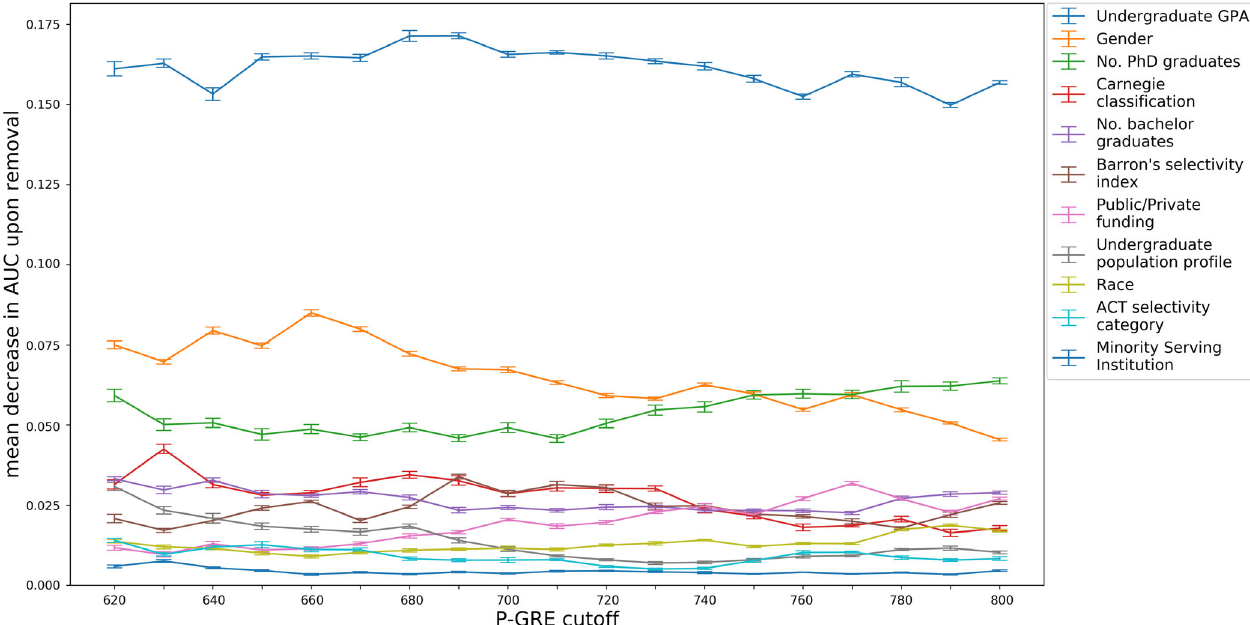
FIG. 5. Conditional inference forest feature importance measures. The standard errors of the K -fold ( K ¼ 10 ) estimates are indicated by the error bars. Features included in the CIF are listed in the legend in decreasing order of average (across all cutoffs) decrease in AUC upon